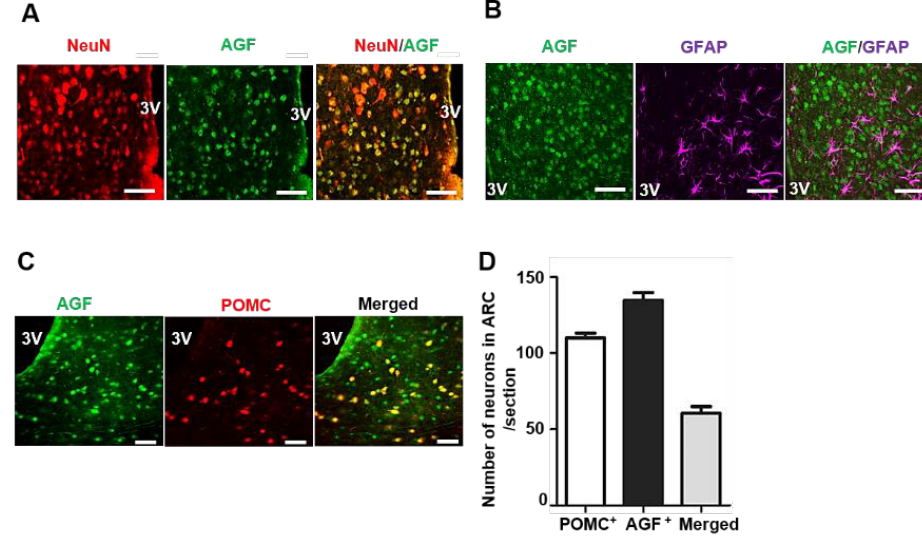
Figure 1. Angiopoietin-like growth factor (AGF) is expressed in the hypothalamus . ( A ) Immuno- histochemical detection of AGF in the human brain. The boxed area within the image indicates a magnified field. ( B ) Agf mRNA expression in the hypothalamus of ad libitum-fed , overnight fasted or refed mice, confirmed by qPCR analysis ( n = 5/group). Data represent means ± SEM (* p < 0.05). Scale bars: 50 μm.